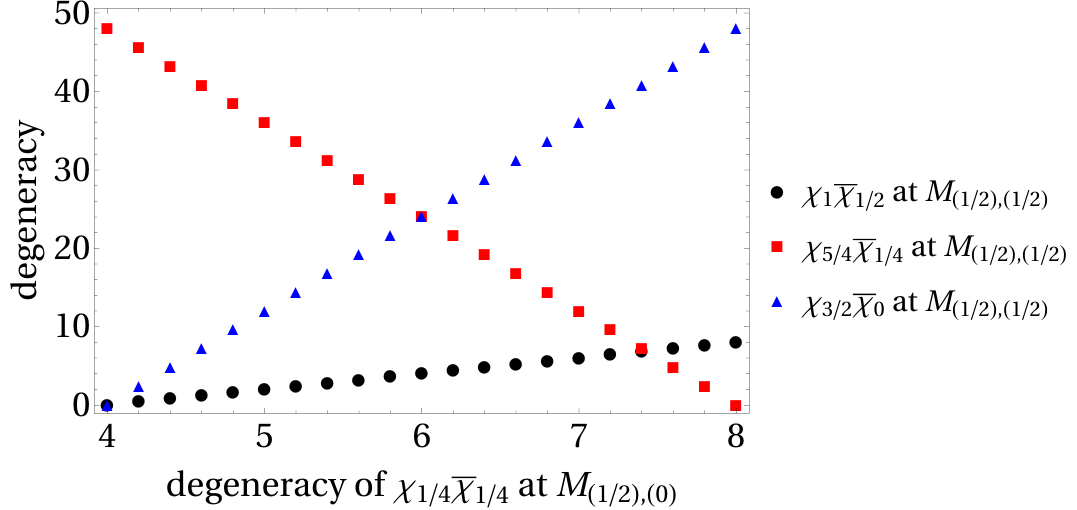
Figure 14 . The linear programming analysis (cid:12)nds a range of possible partition functions if we allow the physical spins to take quarter integer values. When we (cid:12)x one of the degeneracies d by hand, in this case that of the weight ( (cid:22); (cid:22) (cid:22); h (0) ; (cid:22) h (0) ) = ( 1 uniquely determined, so that we (cid:12)nd a one-parameter family of solutions. The degeneracy on the x-axis here is 4 + x in the notation used in the